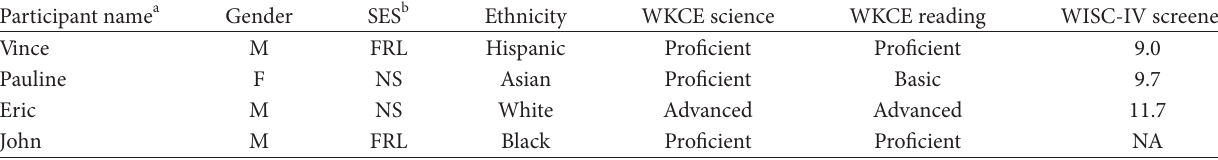
T 1: Demographic information and prior achievement data for SREP